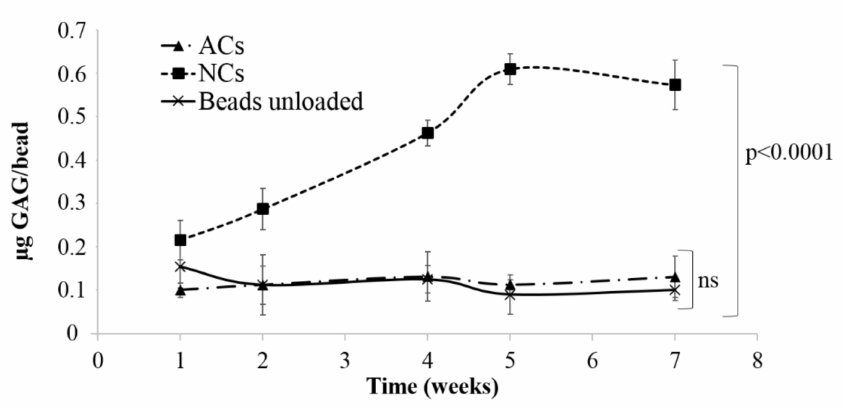
Figure 3. Mean values and standard deviation of µ g GAG/bead, produced by encapsulated articular (ACs) and nasal (NCs) chondrocytes after 1, 2, 4, 5, and 7 weeks of culture. At each considered time, three beads were analyzed to determine the GAG production; overall, six cell lines were considered for ACs and six cell lines were considered for NCs. Unloaded beads were considered as the negative control (experimental sampe size =